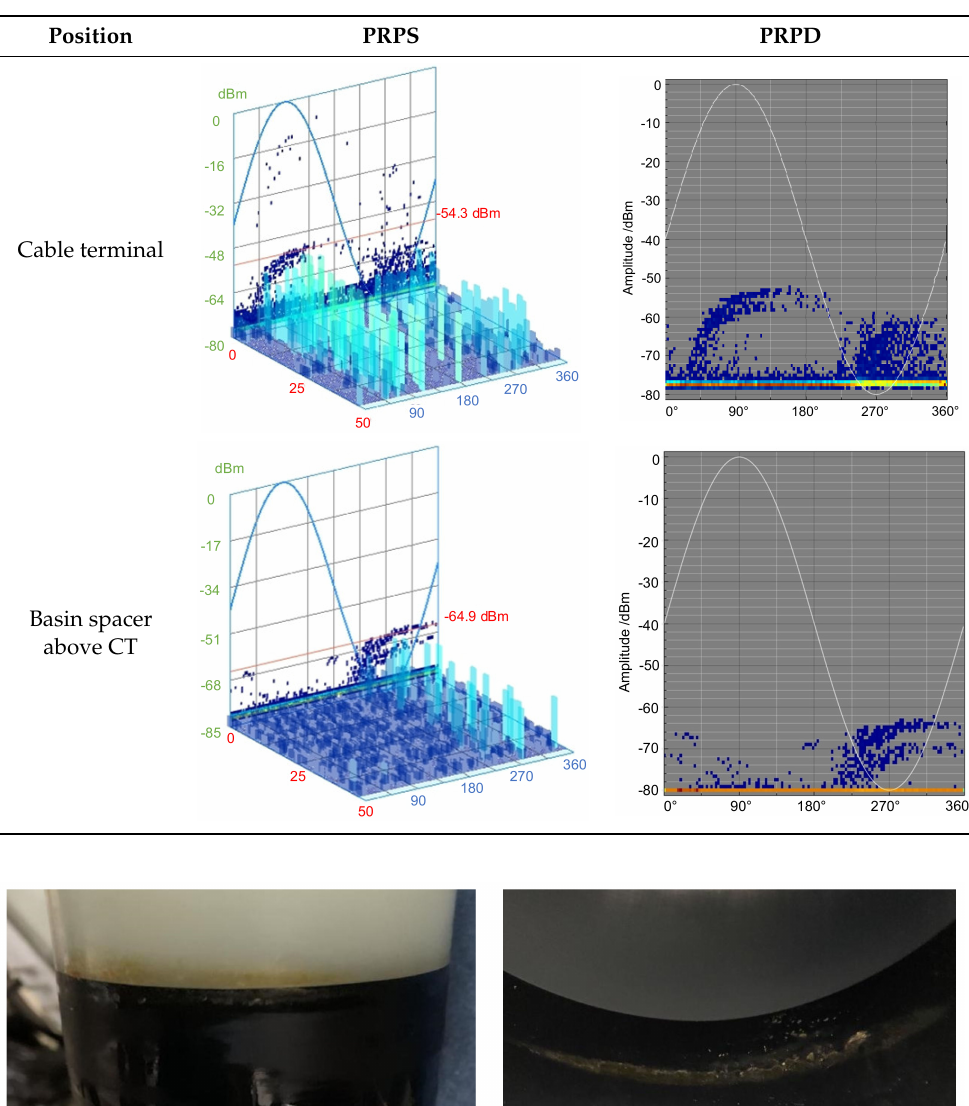
Table 2. Typical spectrum of UHF detection in A-phase cable compartment.